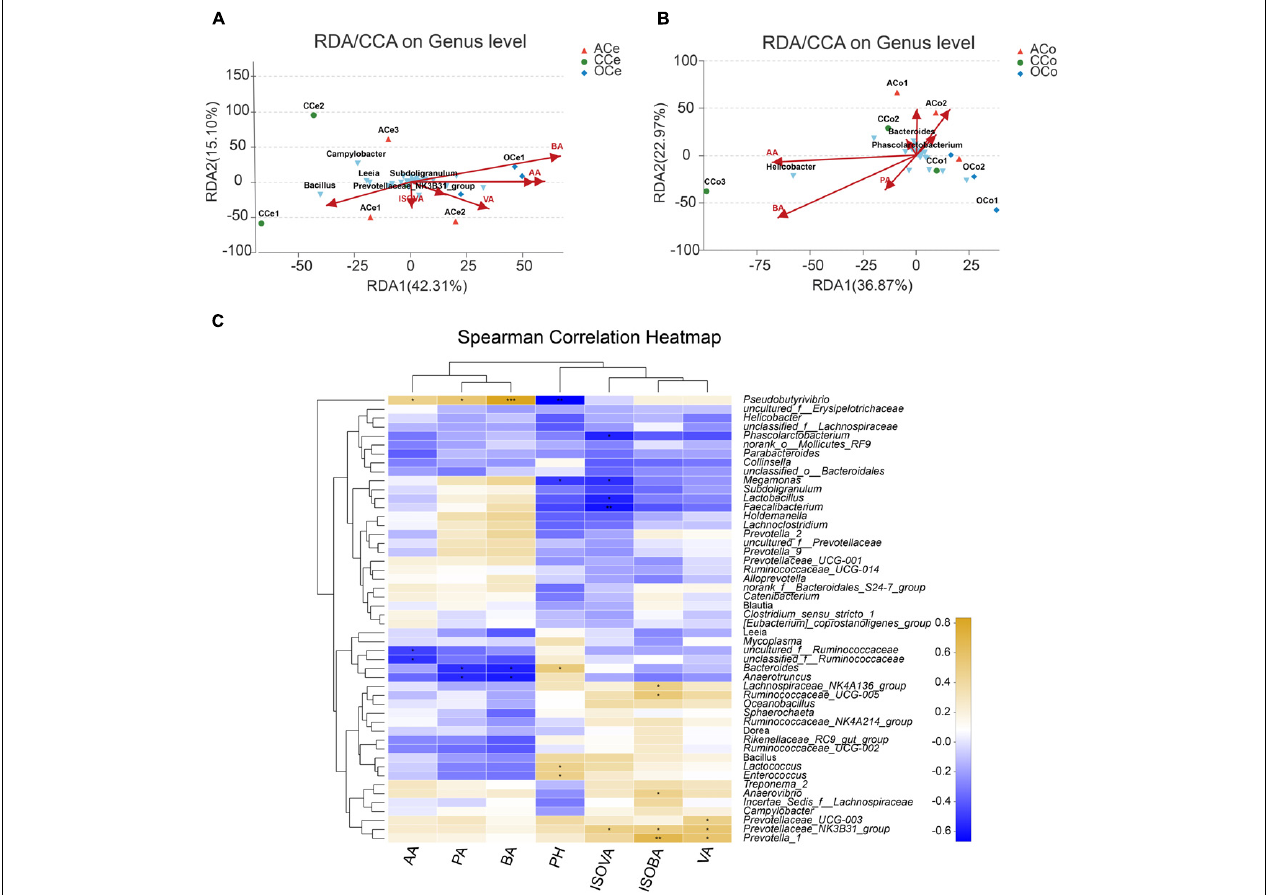
FIGURE 6 | Association and model predictive analysis. (A) RDA targeting only cecum samples. (B) RDA targeting only colon samples. (C) Heatmap of the correlation analysis was conducted between the top 50 bacterial genera and the environmental factors. AA, acetic acid; PA, propionic acid; BA, butyric acid; ISOBA, isobutyric acid; VA, valeric acid; ISOVA, isovaleric acid. ∗ 0.01 < P < = 0.05, ∗∗ 0.001 < P < = 0.01, ∗∗∗ P < =